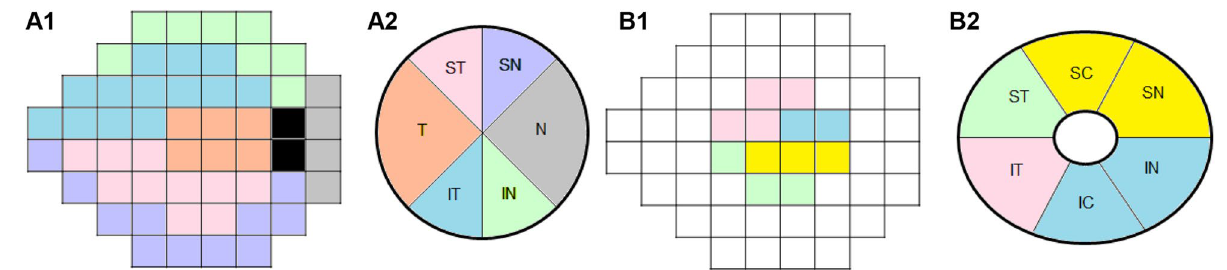
Figure 1. Vasculature– and structure–function correspondence map: visual field (VF) sectors ( A1 ) and corresponding circumpapillary vessel density and retinal nerve fiber layer thickness sectors ( A2 ). VF sectors ◦ within the central 10 VF area ( B1 ) and corresponding macular vessel density and ganglion cell-inner plexiform layer thickness sectors ( B2 ). IC inferocenter, IN inferonasal, IT inferotemporal, N nasal, SC superocenter, ST superotemporal, SN superonasal, T temporal, VF visual